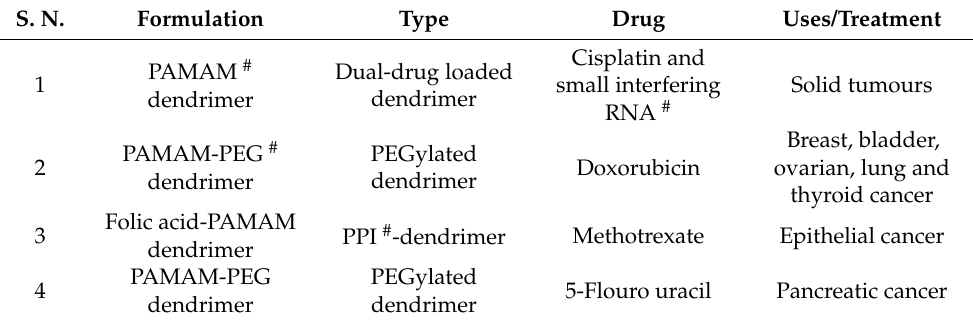
Table 2. Dendrimer for cancer treatment in clinical trials [53]. S. N. Formulation Type Drug Uses/Treatment Cisplatin and Dual-drug loaded PAMAM # dendrimer dendrimer RNA #